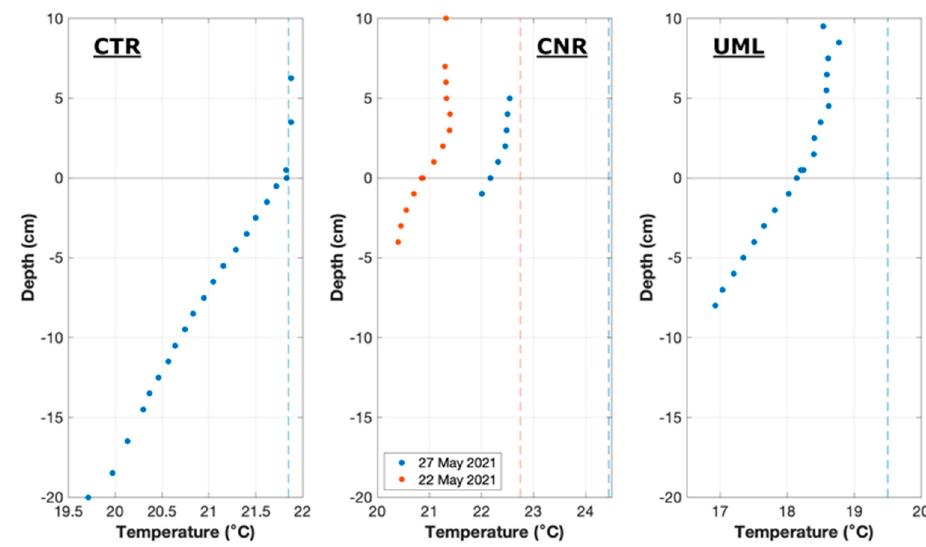
Figure 4. Temperature profiles at all sites. Surface temperatures are shown with dashed lines, and profile from a preliminary field trial at CNR is also shown for comparison. Sediment temperature gradients were estimated as 0.1 °C/cm at CTR, 0.15 °C/cm at CNR, and 0.17 °C/cm at UML.